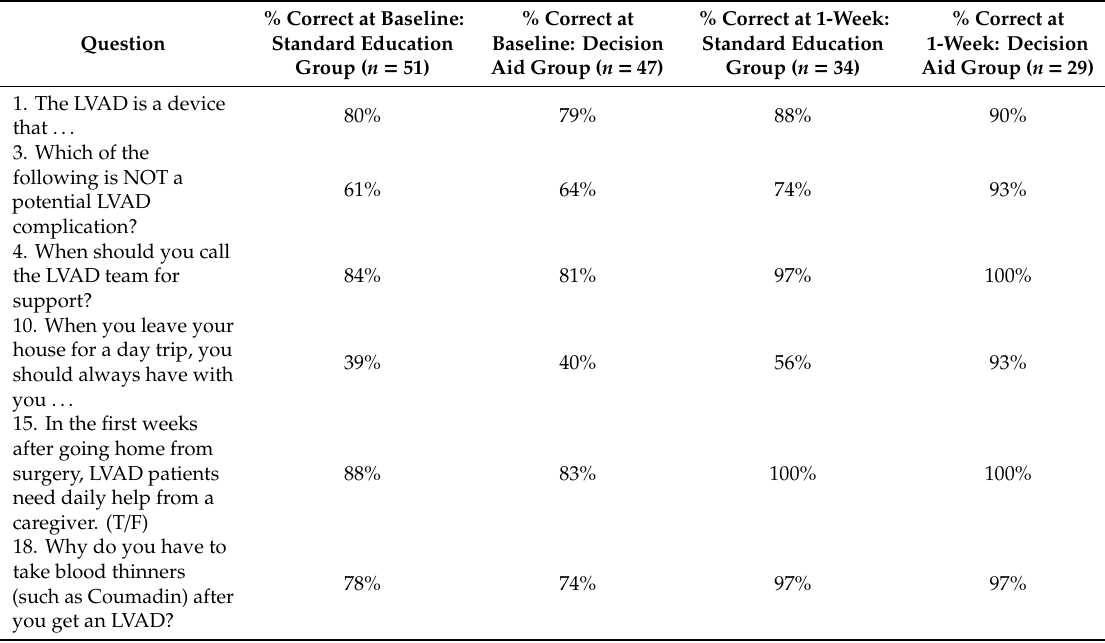
Table 1. LVAD knowledge items answered correct most frequently across the baseline and